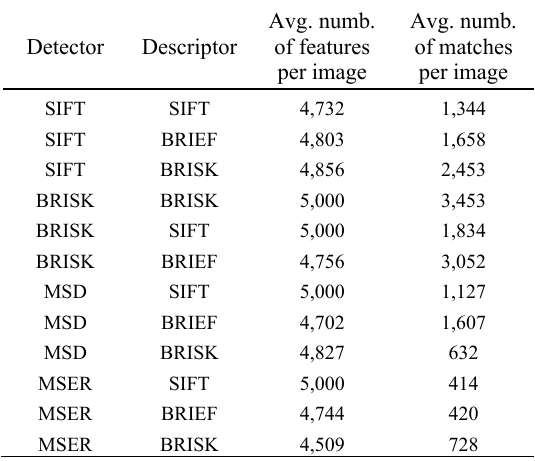
Table 1: Various combinations of detectors/descriptors for the Figure 3: A view of the extracted correspondences between two Dortmund dataset (with a limit of 5,000 features per image). images.